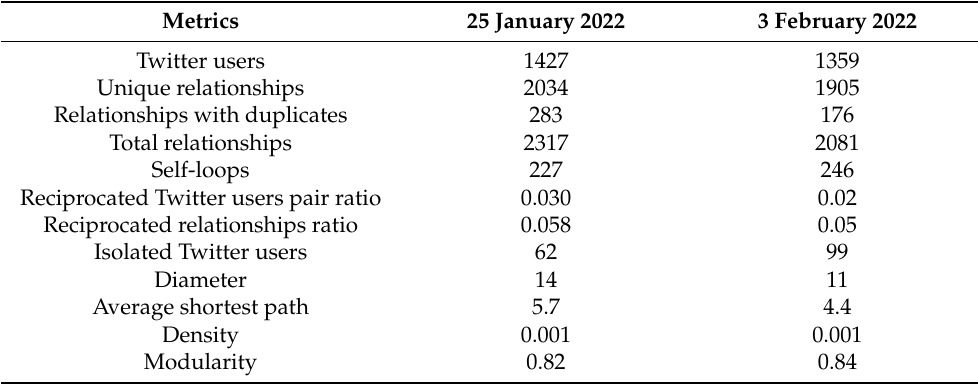
Table 1. Macroscopic characteristics of the